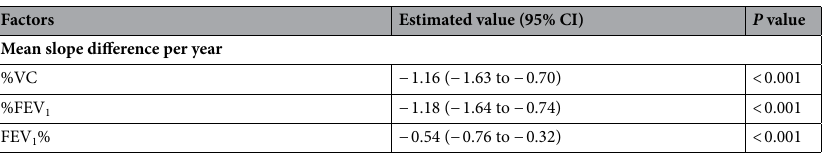
Factors Estimated value (95% CI)